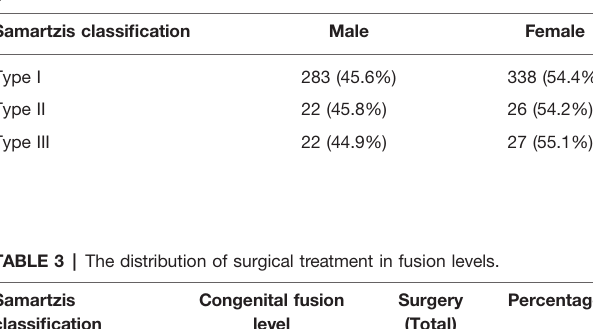
TABLE 2 | The incidence of Klippel – Feil syndrome (KFS) classi fi cation types to gender.